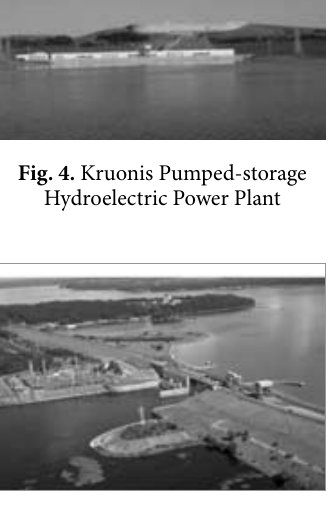
Fig. 5. Kaunas Hydroelectric Power